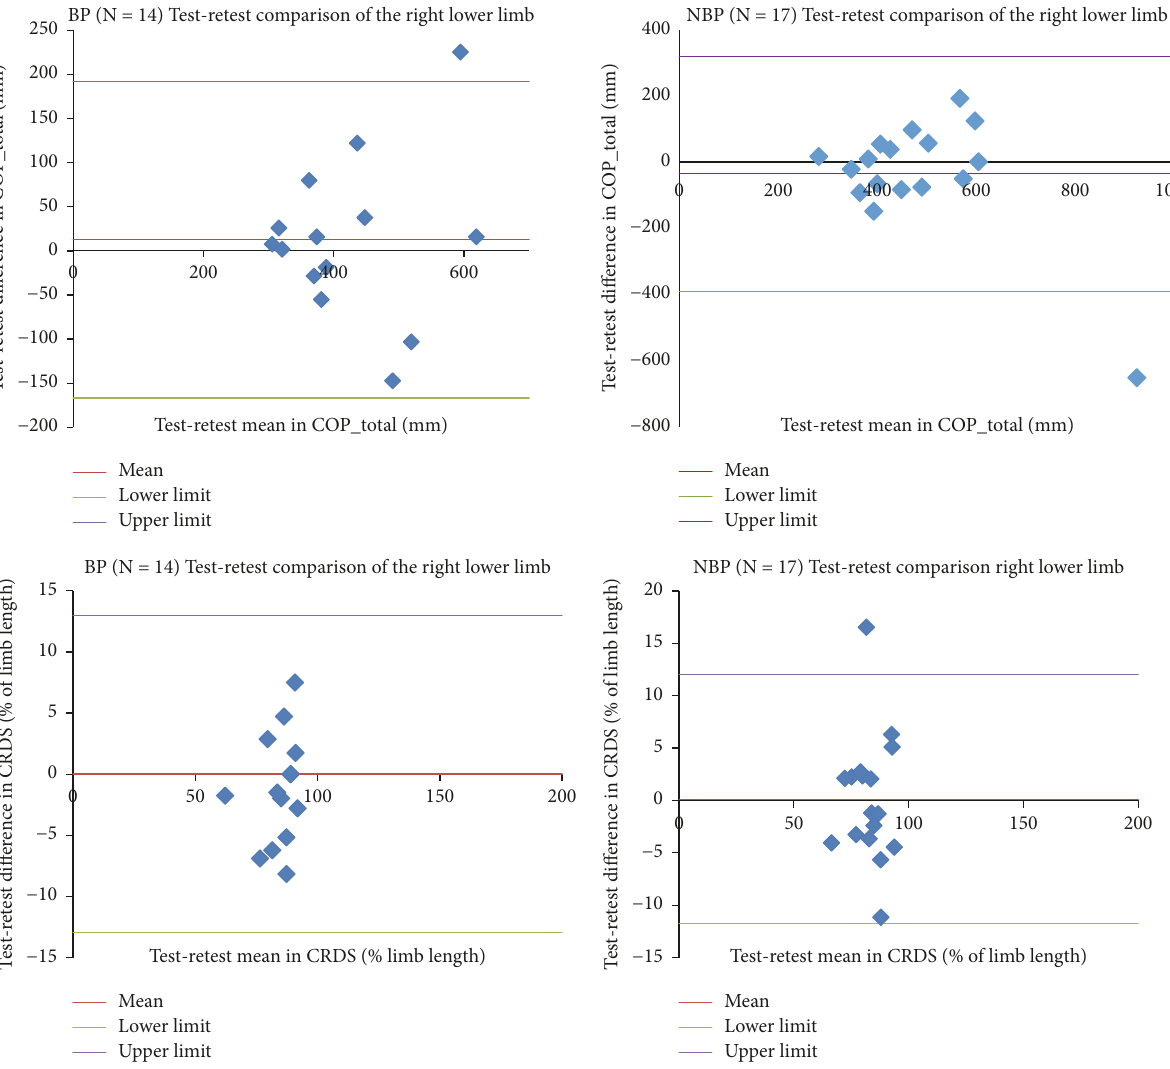
Figure 1: Bland-Altman plot for the right lower limb of adolescent athletes with and without back pain on the one-legged stance test and the star excursion balance test. Blue diamond: single values; mean – (bias); lower limit (bias – 1.96 ∗ standard deviation); upper limit (bias + 1.96 ∗ standard